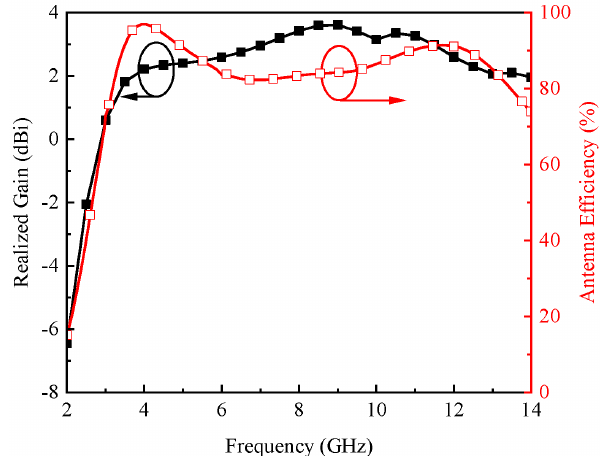
Figure 9. Realized gain and efficiency of the proposed CPW-fed pentagonal fractal